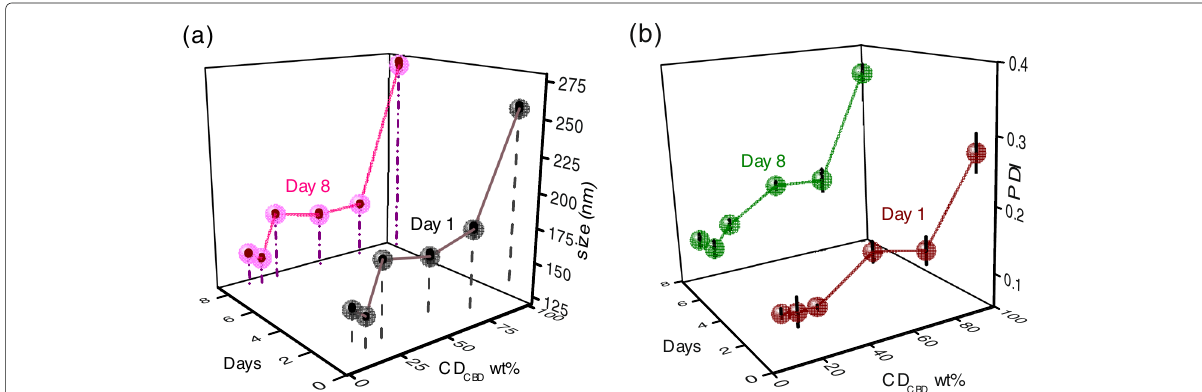
Fig. 5 Variation of a d z and b PDI of a phytocannabinoid nanoemulsion, immediately upon fabrication, and after a week, as a function of the wt% of CD CBD in the lipid phase of the